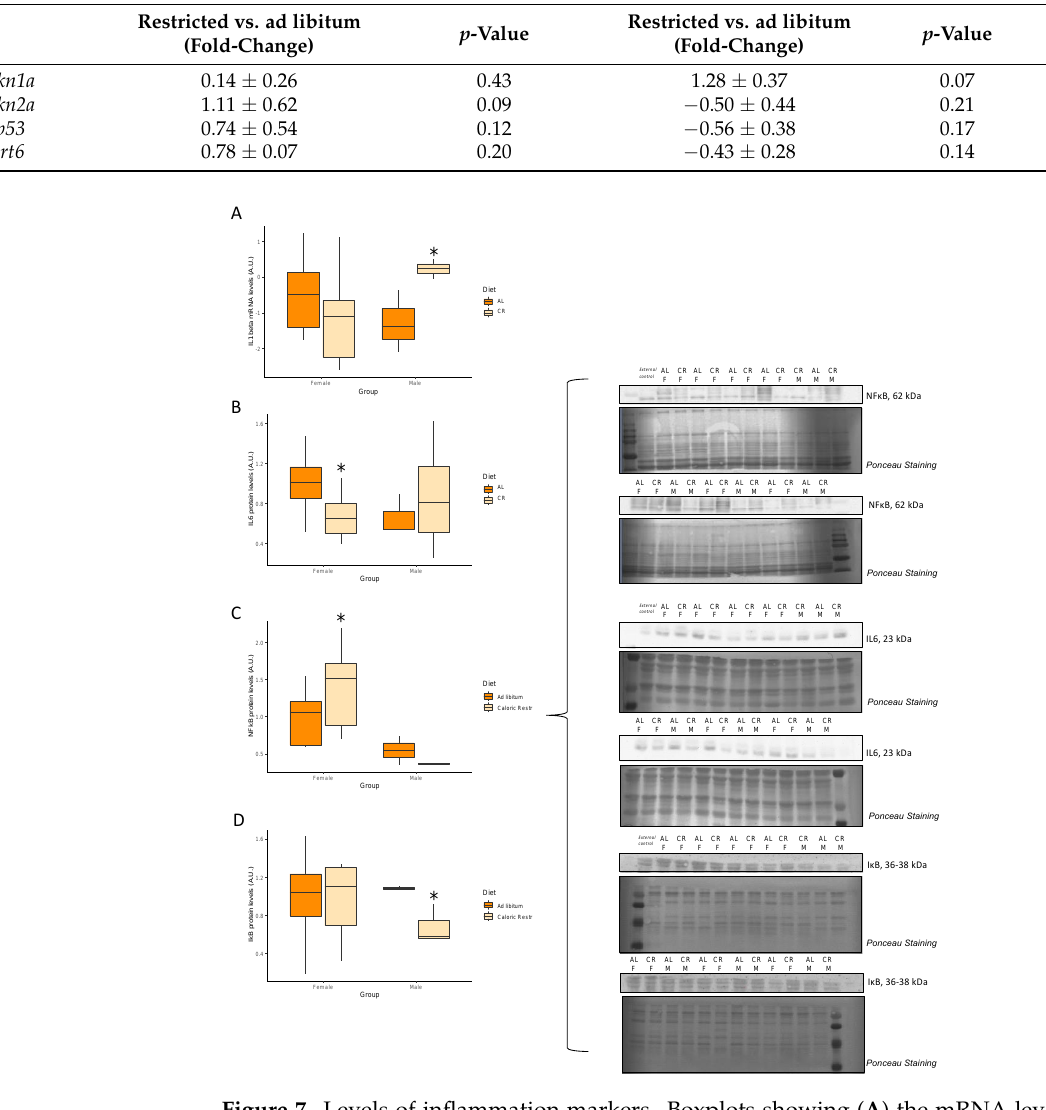
Figure 7. Levels of inflammation markers. Boxplots showing ( A ) the mRNA levels of IL1B , and the protein levels of ( B ) IL6, ( C ) NFκB, and ( D ) Iκ B, and representative bands of the Western blot. Abbreviations: AL: ad libitum; CR: caloric restriction; F: female; M: male. * Significant difference between calorie-restricted and control group.